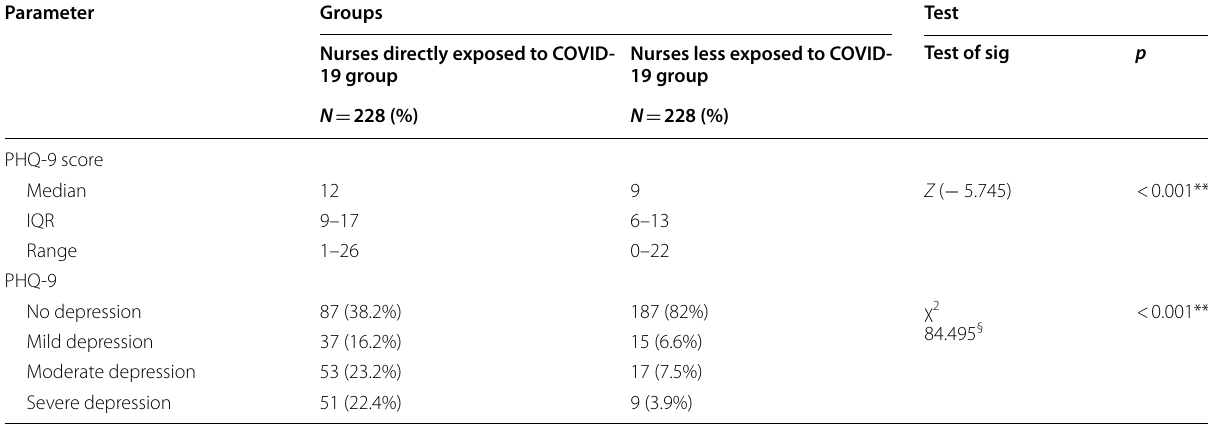
Table 3 Comparison between the studied groups regarding Patient Health Questionnaire (PHQ) score